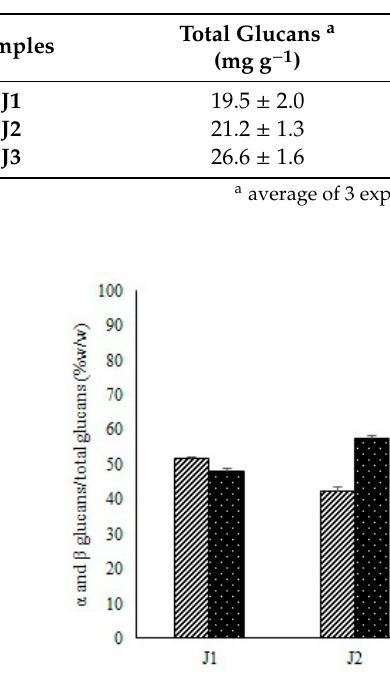
Figure 4. Percentage content of α - and β -glucans compared to total glucans.